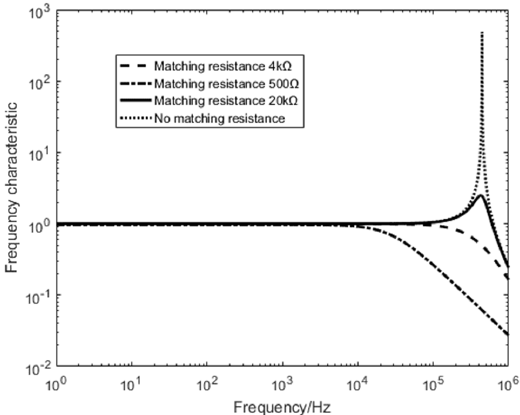
Figure 4. Sensor coil amplitude frequency characteristic diagram.